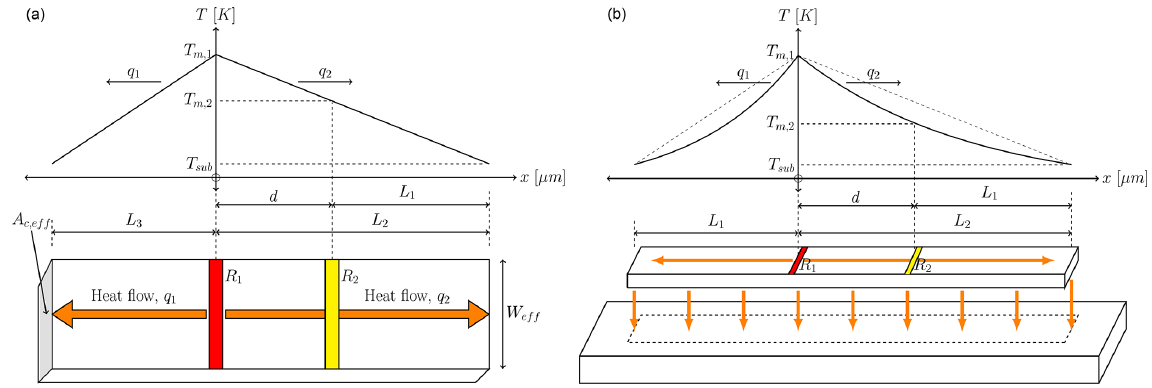
Figure 2. A microbeam with two resistive strips and the relevant dimensions, along with the expected temperature profiles over the length of the bar. (a) The temperature profile through a microbeam when heat flow occurs only through the microbeam is typical under vacuum conditions. (b) The temperature profile through a microbeam when heat flow occurs through both the solid components of the microbeam, as well as the medium (either a gas or a fluid) between the microbeam and a heat